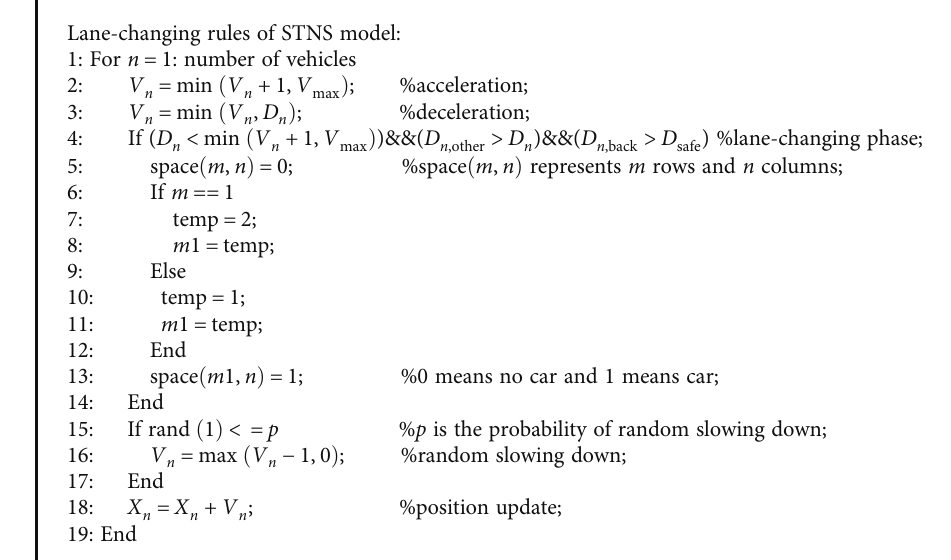
Algorithm 2: Lane-changing rules of STNS model.